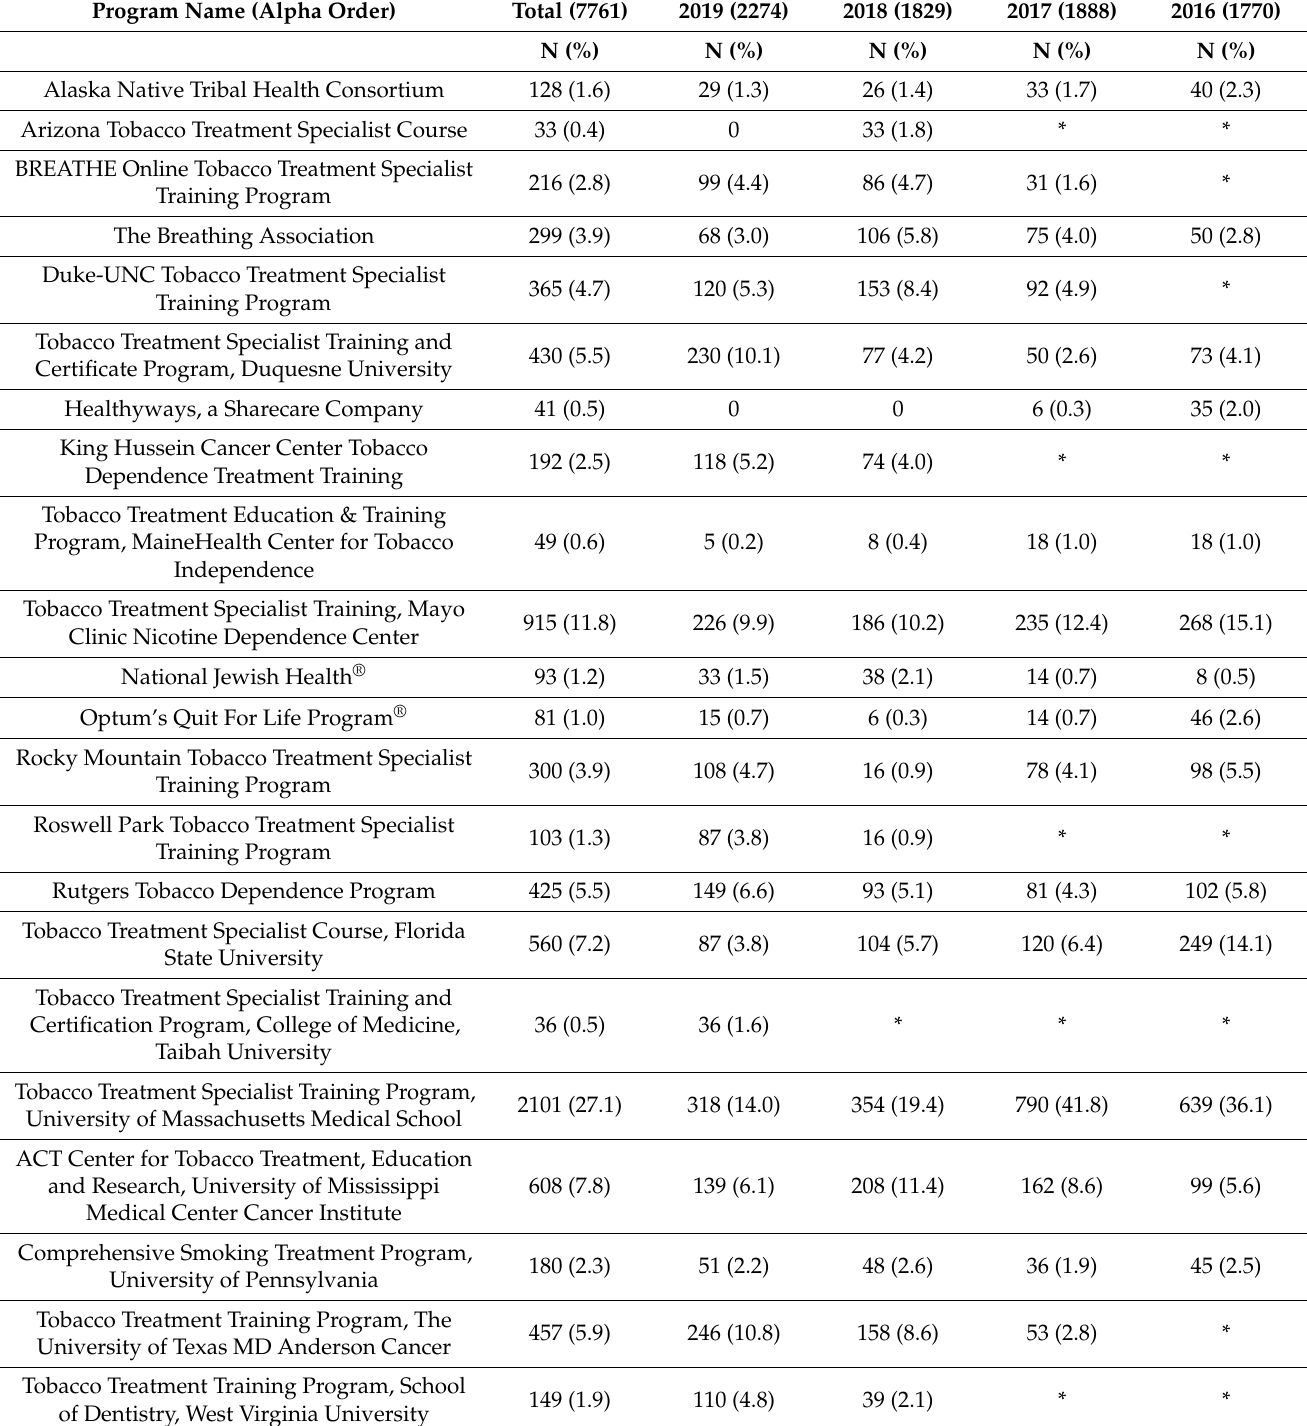
Table 2. Number of Trainees by Training Program